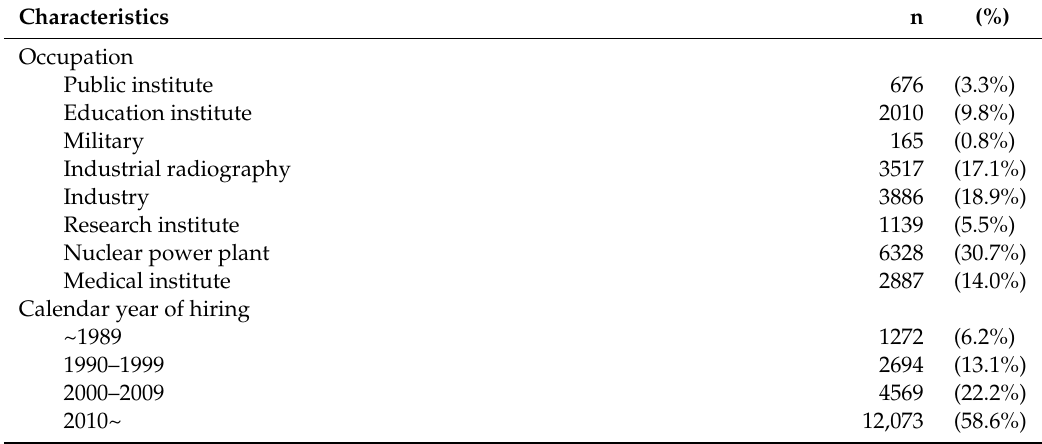
Table 2. Occupational characteristics of the cohort (N =